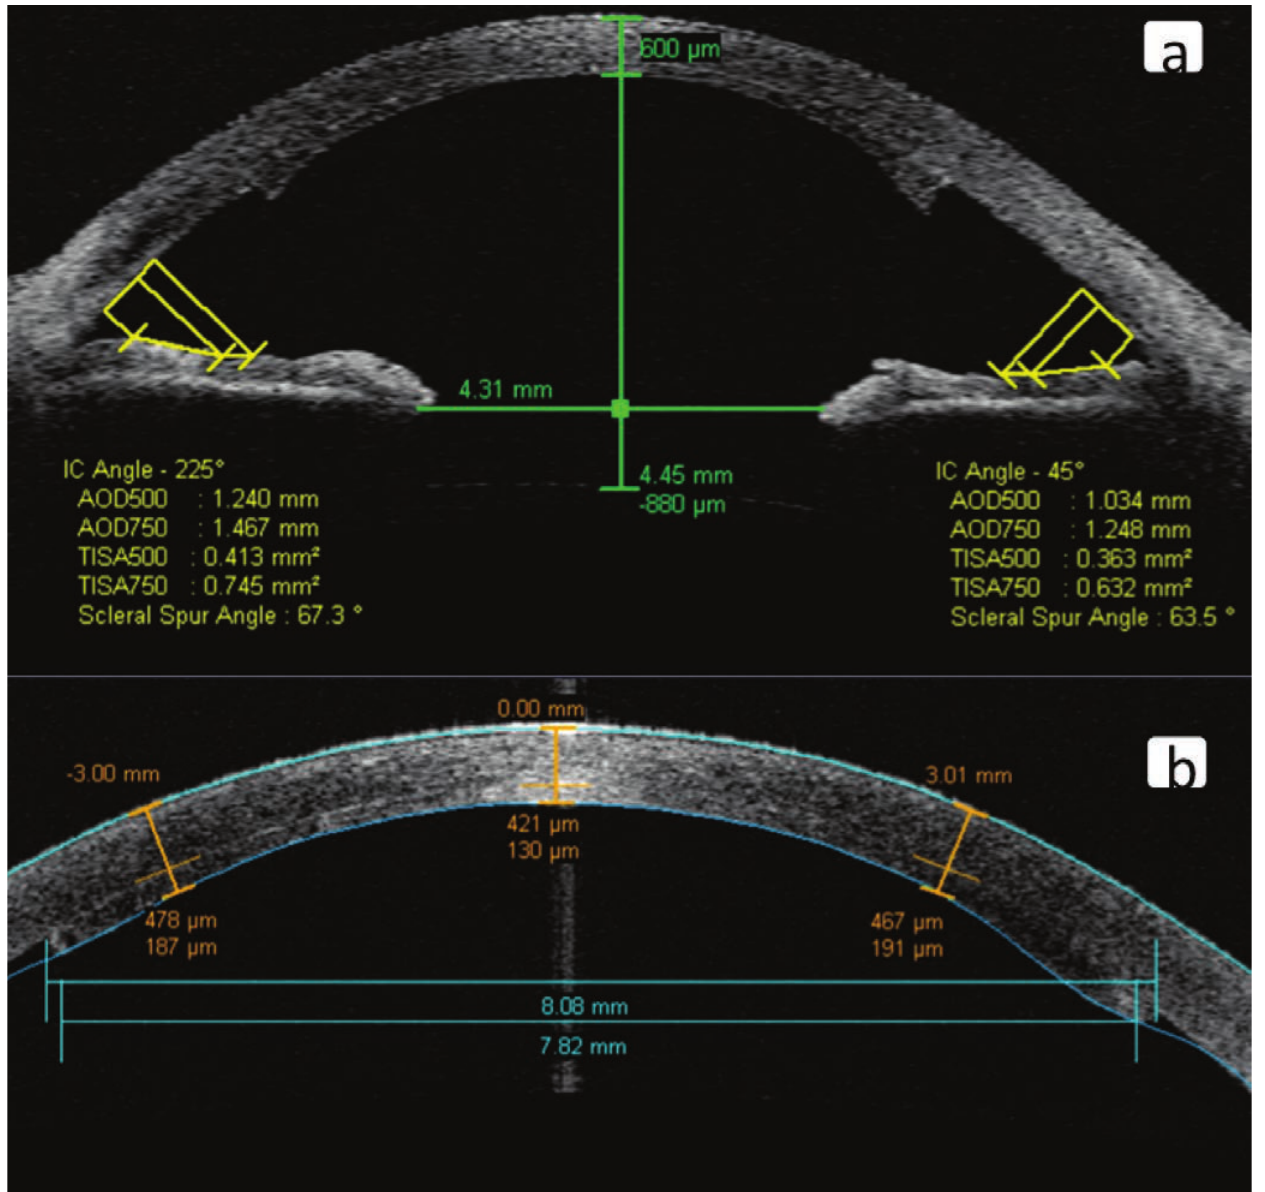
Figure 1. (a) Anterior chamber angle parameters were measured by AS-OCT. (b) Anterior chamber depth, corneal thickness, and graft